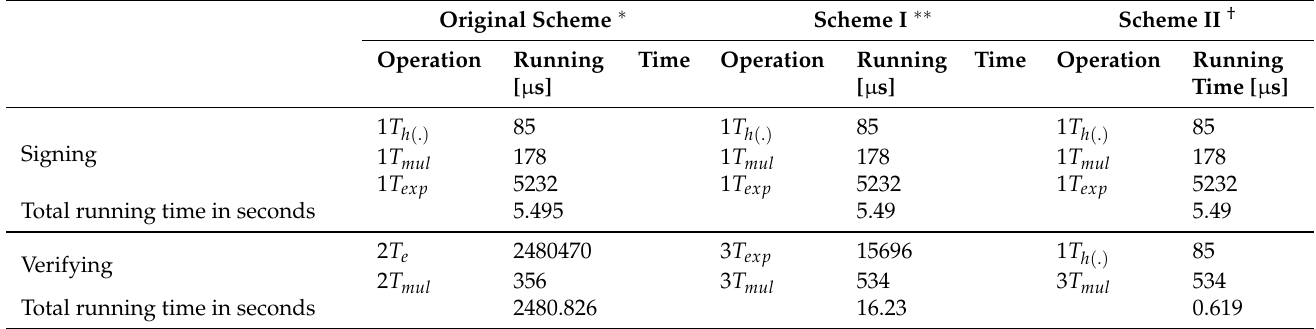
Table 5. Efficiency comparison in smartphone platform.